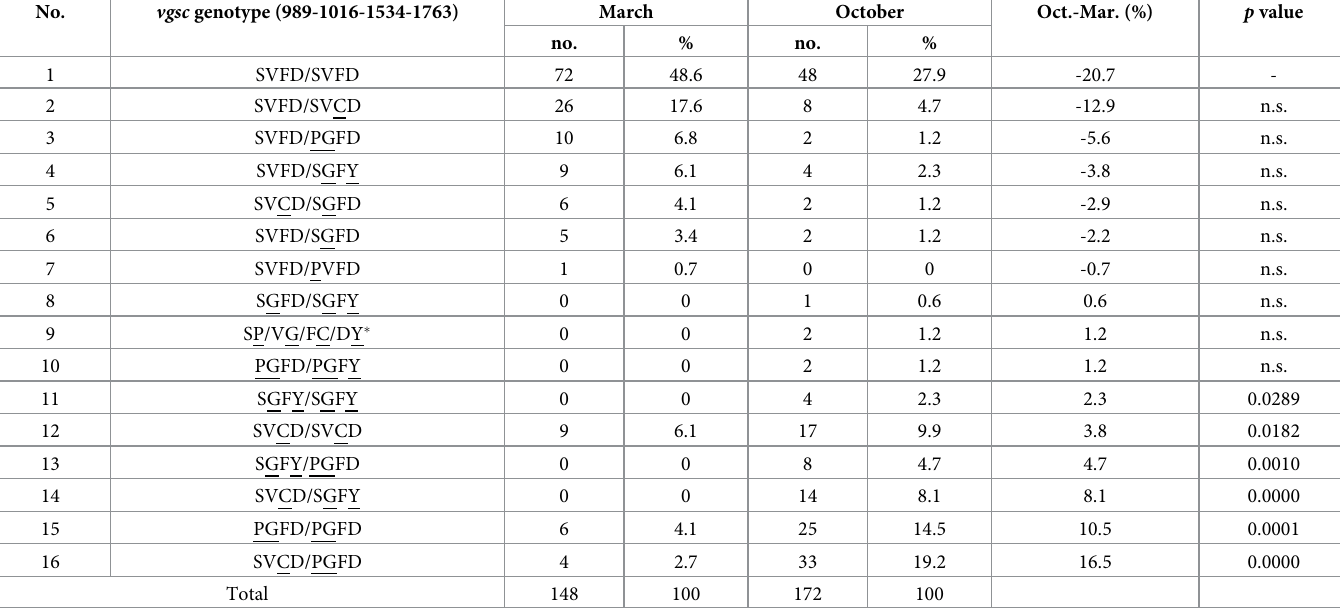
mosquitoes than in dead mosquitoes (S989P and V1016G were significantly higher) ( p < 0.001) (Fig 3). The mutant alleles in 989 and 1016 (heterozygous and homozygous) were significantly higher ( p < 0.01) in alive mosquitoes (22, 3, 23, and 11) than in dead mosquitoes (4, 0, 18, and 0) compared with those of the wild type (S989: 12 live, 74 dead and V1016: 3 live, 60 dead) (Table 3). The mutant alleles in 1534 heterozygous and 1763 homozygous were also significantly higher ( p < 0.01) in alive mosquitoes than in dead mosquitoes. We further Table 2. The distribution of combined vgsc genotypes in field-collected male Ae . aegypti in March and October. Genotype was described as the composition of two haplotypes and underlined letter represents the mutant alleles in each position. No. vgsc genotype